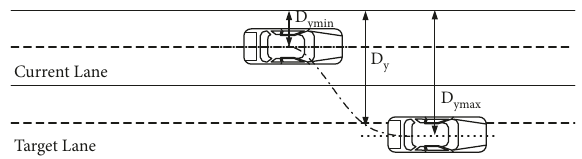
Figure 4: Lateral offset of the vehicle.